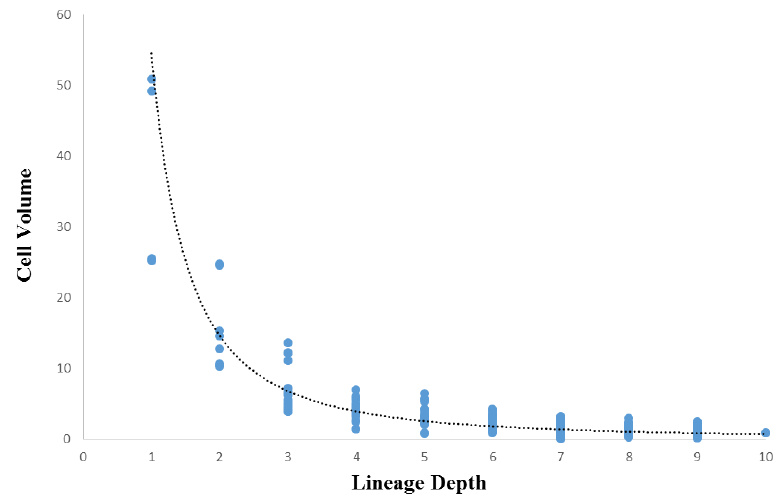
Figure 7. Comparison of cell volume versus lineage depth for Ciona . The graph includes 382 cells from the two-cell stage to the 112-cell stage. Lineage depth is determined by the number of division events from the one-cell stage (depth of 0).